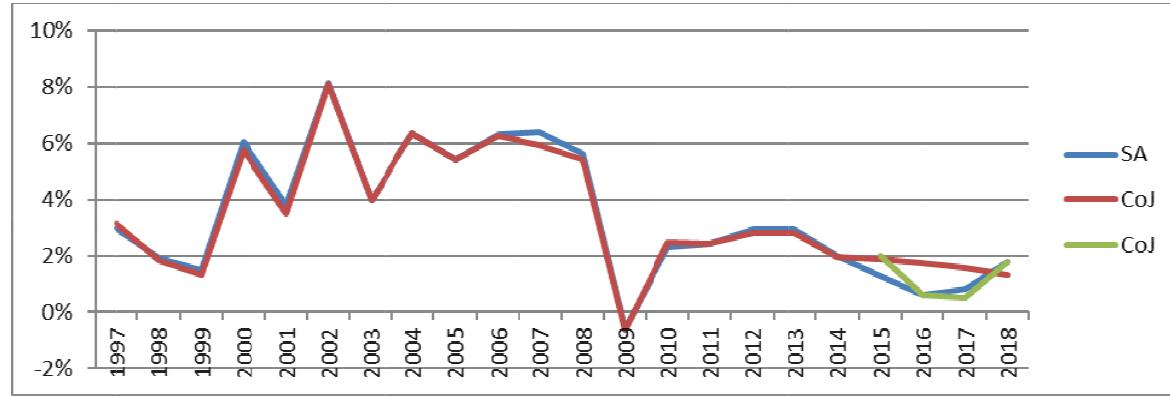
Fig. 2. Year on Global Insight